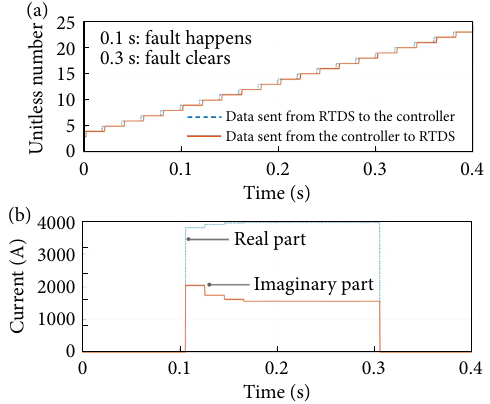
Fig. 5 Results for single-phase-to-ground faults with learning-based AFM. ( a ) Timestamp signals sent between RTDS simulators and the controller. ( b ) Microgrid 1’s phase currents sent from the controller to RTDS simulators. Figure 6 includes fault currents at fault locations, and the mag- nitude difference between total fault currents and fault current from the main grid, i.e., . Total fault current and fault current from the main grid are 184.0 A and 176.1 A, respec-